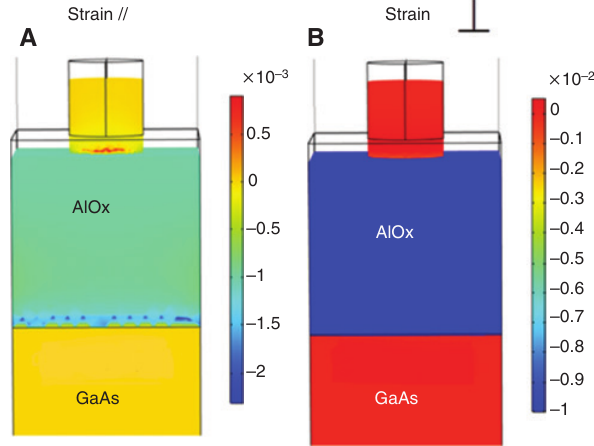
Figure 5: Finite-element map of the oxidation-induced strain on the nanoantenna parallel (A) and perpendicular (B) to the wafer plane. The latter is zero, whereas the former is much lower than the typical values that induce a nonvanishing χ (2) in silicon.